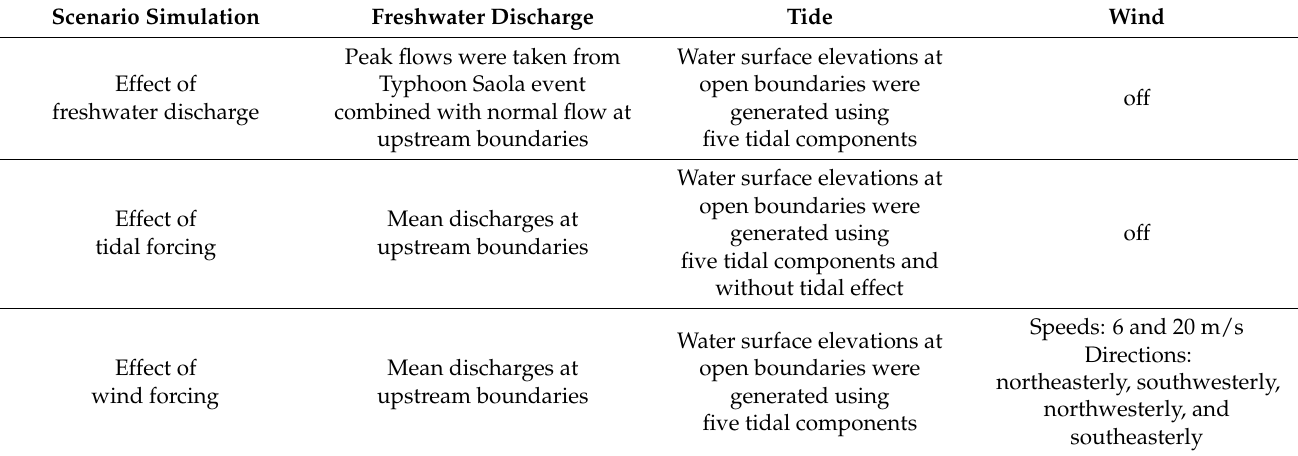
Table 2. Model configurations for scenario